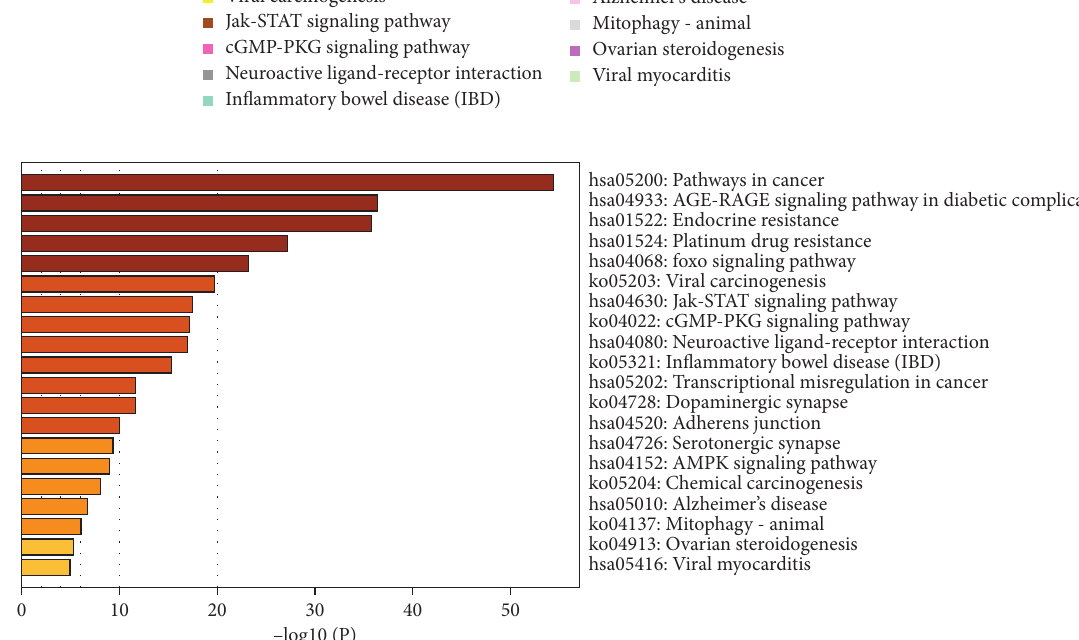
Figure 2: The KEGG pathway enrichment